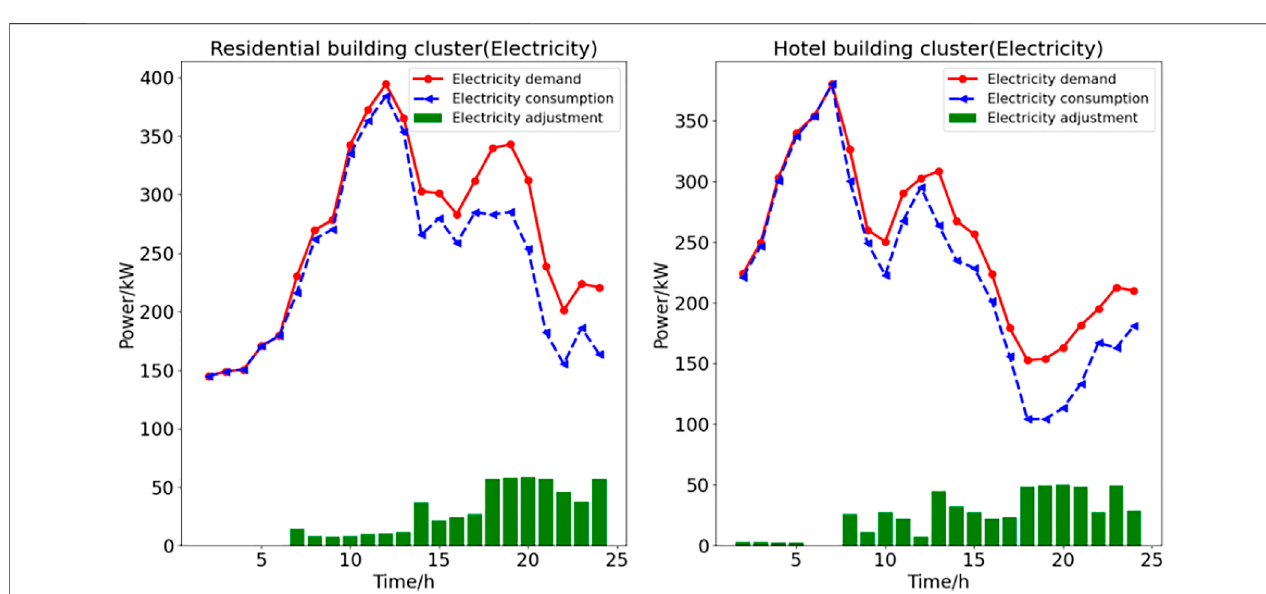
FIGURE 11 | Real energy consumption curves of other